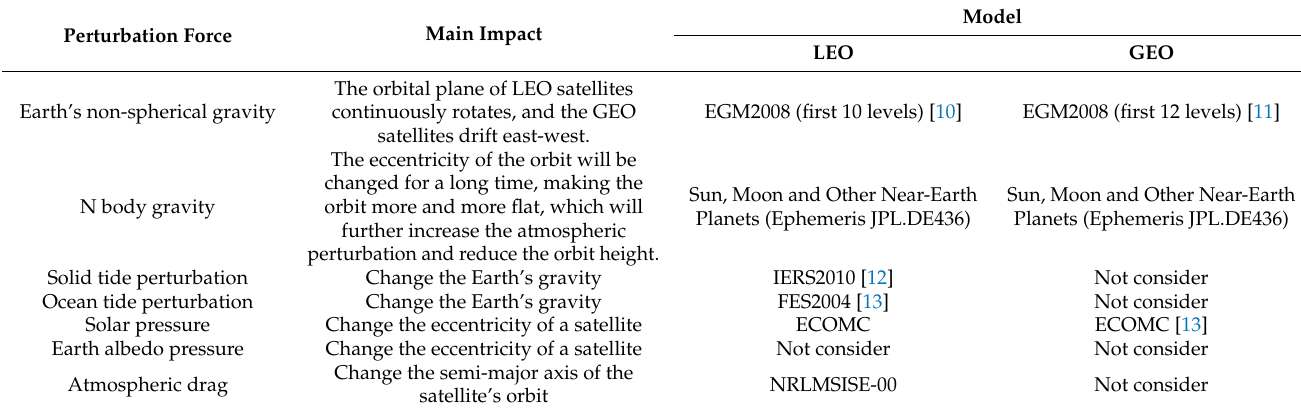
Figure 3. Relationship between Keplerian parameters and geocentric equatorial frame [9]. Table 1. The mechanical models used for various perturbation forces.